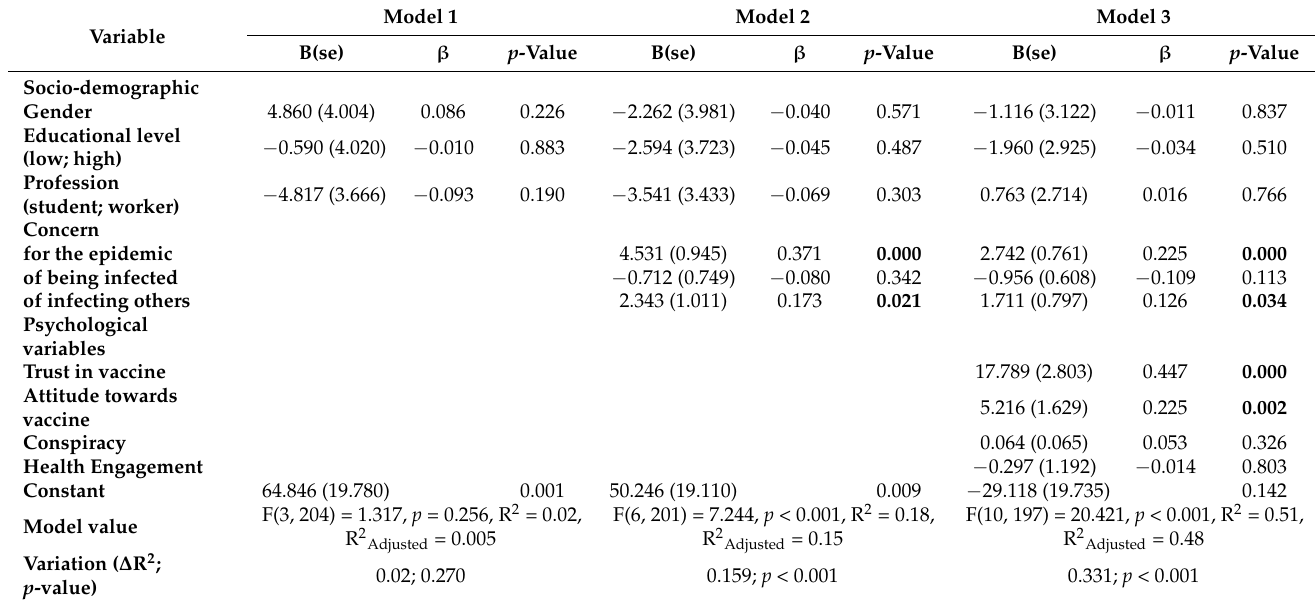
Table 6. Hierarchical regression analysis predictors of intention to receive the COVID-19